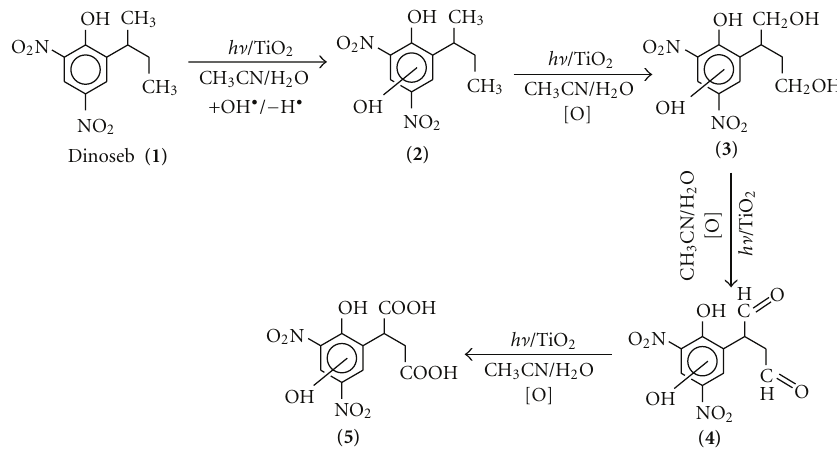
Scheme 1: Probable pathway for the degradation of Dinoseb catalyzed by TiO 2 in the presence of UV light.